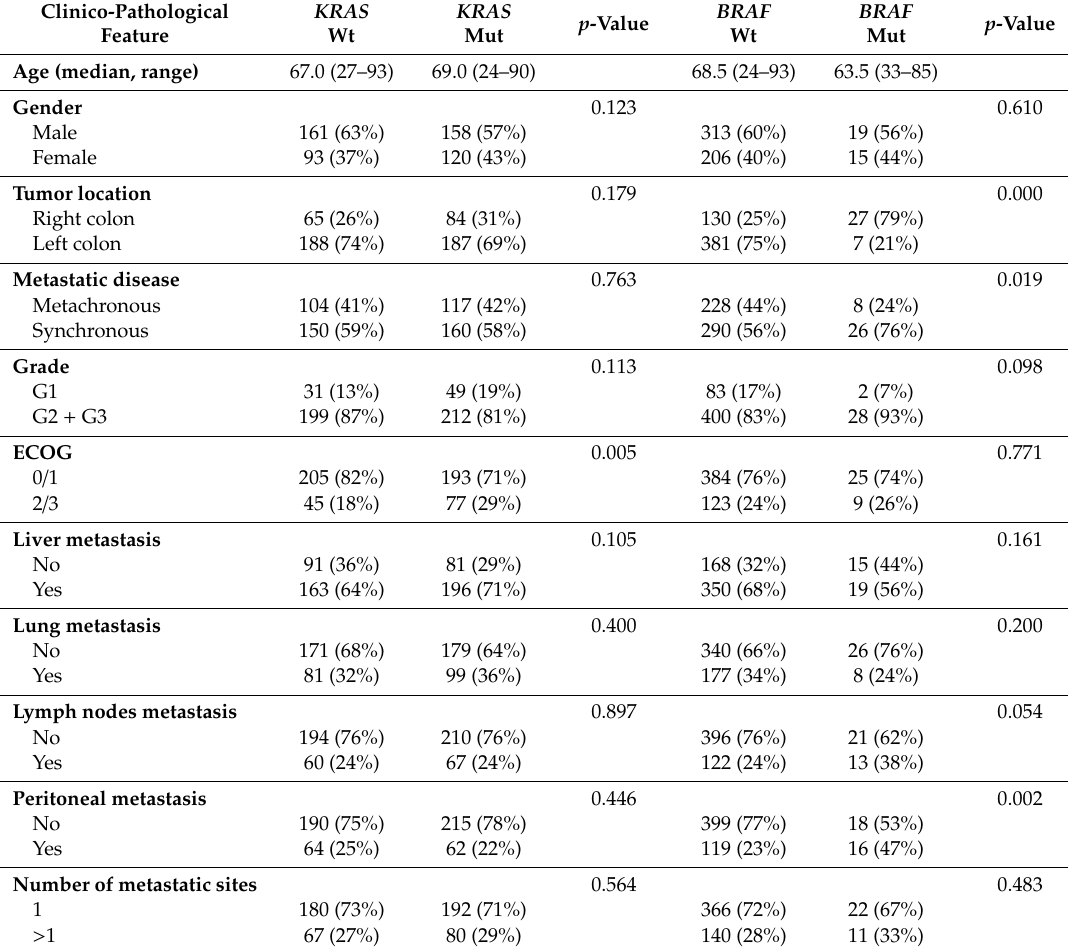
Table 2. Statistical association between KRAS and BRAF mutational status with clinico-pathological features of the